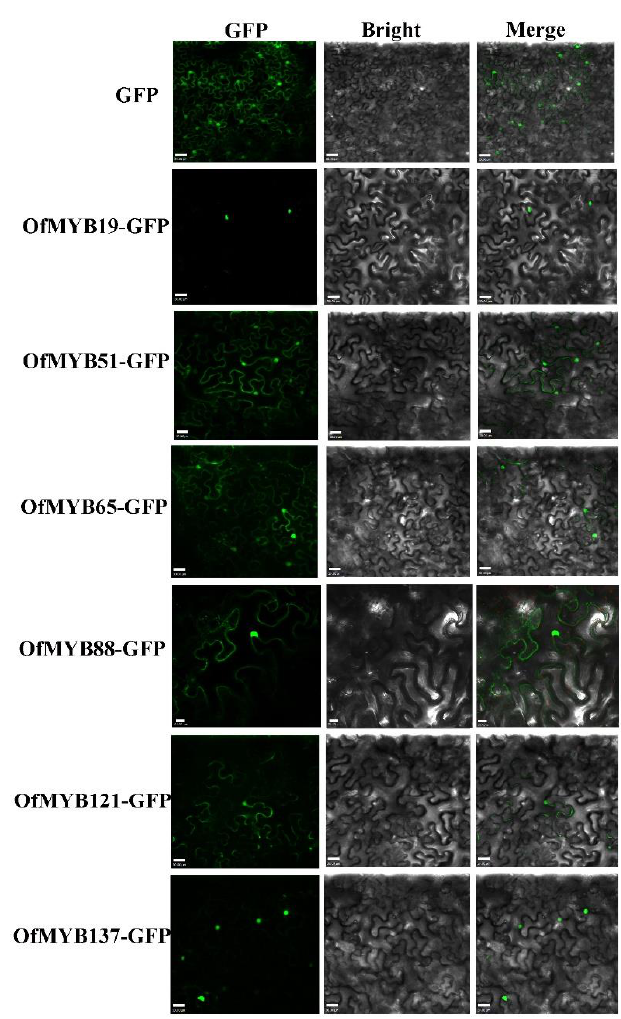
Figure 6. Localization of OfMYB proteins. Subcellular localization analysis of selected 2R-MYB proteins. Transient expression of Super1300-OfMYB fusion and Super1300 construct in tobacco epidermal cells. From right to left, the pictures show fluorescent-field illumination, bright-field, and the overlay of three illuminations. The white block in the lower-left corner is the scale bar.